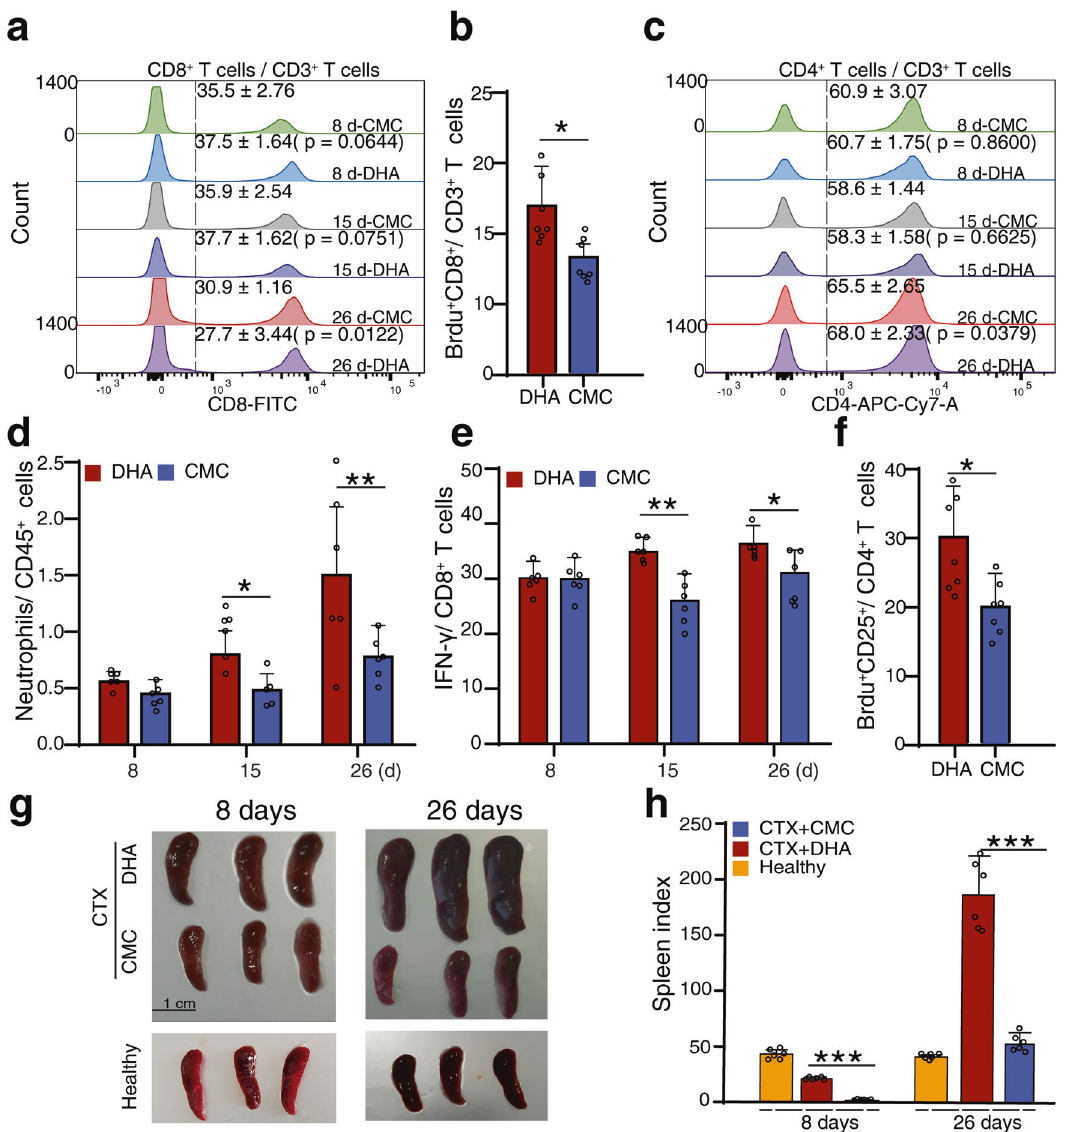
Fig. 1 DHA promoted splenic cell proliferation and immune cell rearrangement in healthy and cyclophosphamide-induced immunosup- pressed mice. a Representative fl ow cytometry histograms and percentages of positive cells from different DHA and CMC groups at different days after staining for cell surface CD45 + CD3 + CD8 + . b Bar graphs represent signi fi cant increase in percentages of Brdu + proliferative CD8 T cells in DHA-treated group compared to CMC-treated group on day 8 post treatment ( n = 7). c Representative fl ow cytometry histograms and percentages of positive cells from different DHA and CMC groups at different days after staining for cell surface CD45 + CD3 + CD4 + . d , e Bar graphs represent signi fi cant increases in percentages of Gr-1 + neutrophils (CD11b + Gr-1 + ) or IFN- γ + CD8 T cells of total CD45 + immune cells in DHA- and CMC-treated mice. f Bar graphs represent signi fi cant increases in percentages of Brdu + CD25 + proliferative CD4 T cells in DHA-treated mice ( n = 7). g , h Representative spleen images and quantitative analysis of spleen index of mice in cyclophosphamide- induced immunosuppressive mice and the healthy control mice. DHA = dihydroartemisinin group, CMC = CMC (carboxymethyl cellulose) solvent solution control. The results are representative of three independent experiments with a minimum of seven mice per group per experiment. * p < 0.05; ** p < 0.01; *** p < (Fig. 4f). These results indicated that DHA triggered MAPK or CDK signaling pathways by phosphorylation of cell cycle-related proteins.